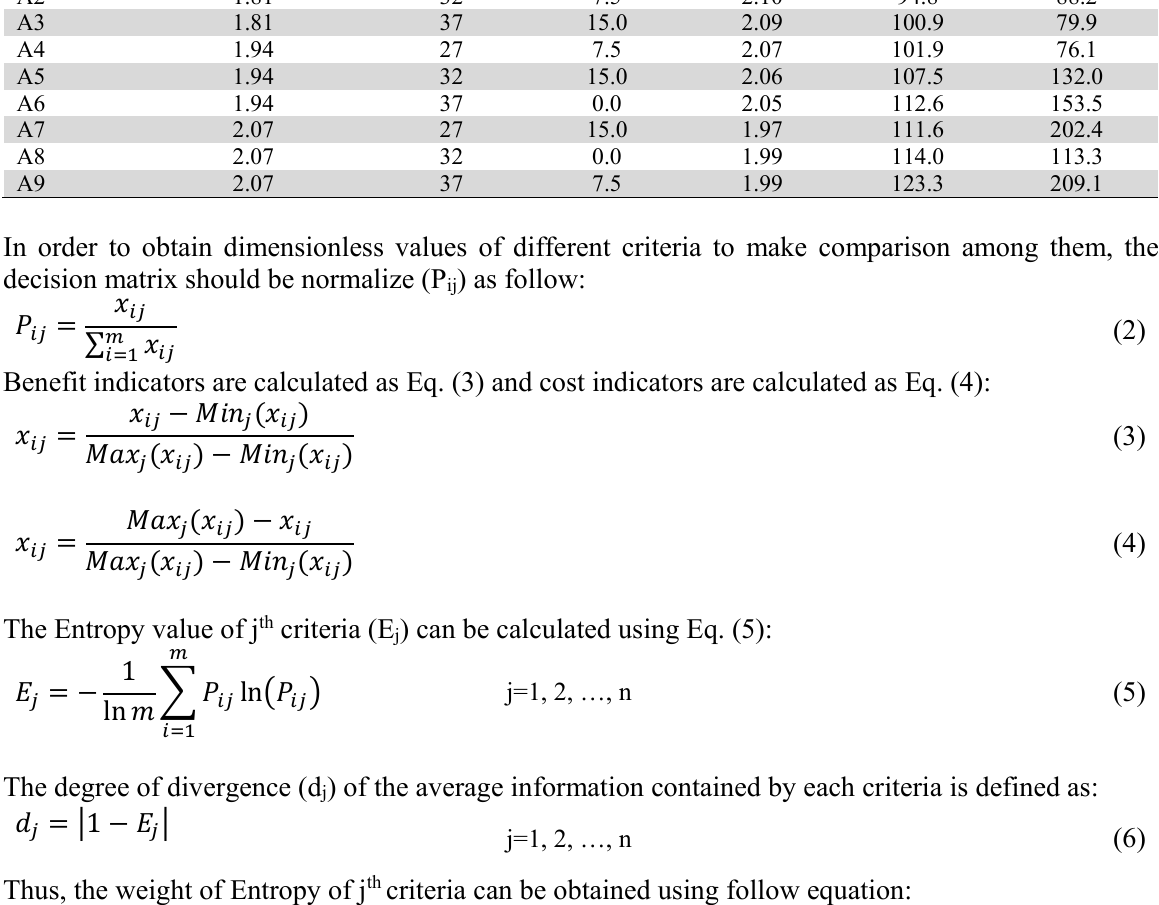
Maximum Pressure